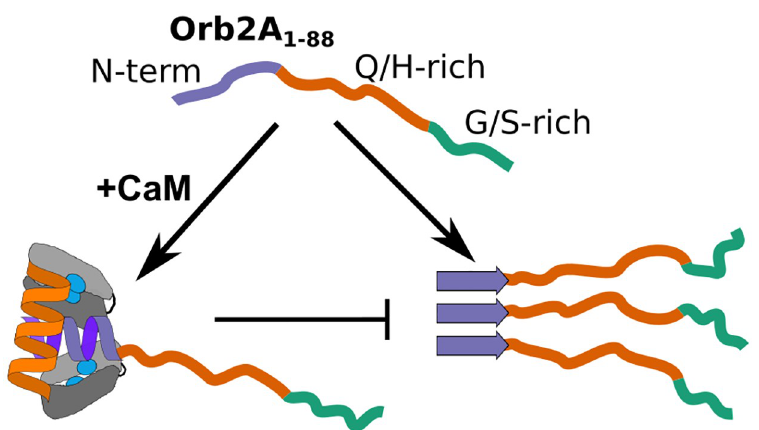
Fig 6. Activated CaM prevents fibril formation of Orb2A 1-88 . Addition of Ca 2+ activated CaM sequesters the N- terminal amphipathic region of Orb2A 1-88 . This interaction prevents the formation of N-terminal β -sheets necessary for cross- β fibril